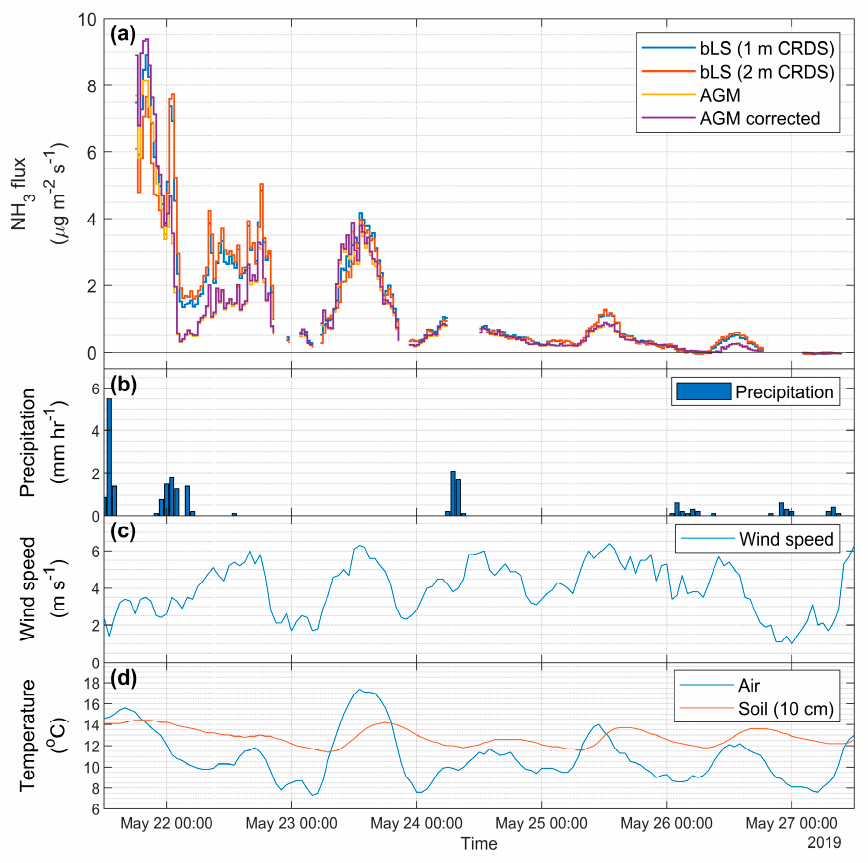
Figure 3. ( a ) Source emission of NH 3 from the measurement campaign in May presented for backward Lagrangian stochastic (bLS) (1-m CRDS), bLS (2-m CRDS), the aerodynamic gradient method (AGM), and the AGM with footprint correction. ( b ) Precipitation per hour, ( c ) wind speed at 10 m, and ( d ) air temperature and soil temperature at 10 cm. Data in ( b – d ) are recorded 5 km NE of the field. Table 2. Mean emissions of the measurement campaigns in May and August in µ g m − 2 s − 1 for filtered data over the measurement period. AGM: aerodynamic gradient method, bLS: backward Lagrangian stochastic, CRDS: cavity ring-down spectroscopy, and miniDOAS: differential optical absorption